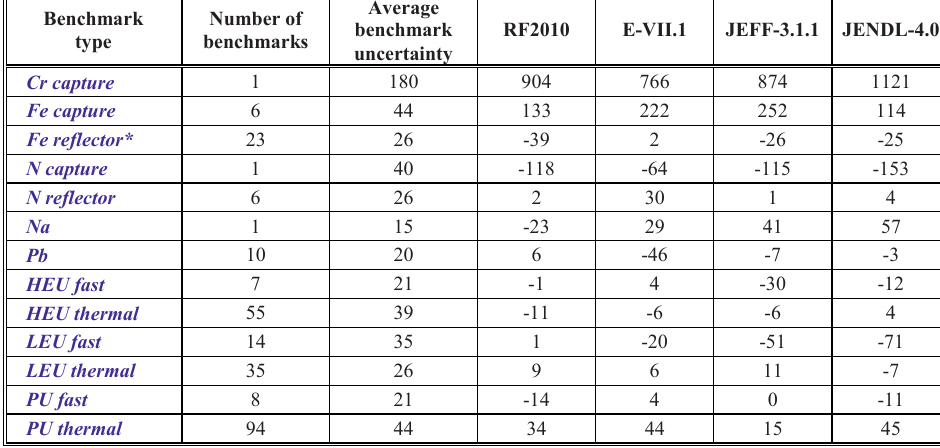
Table 4. The average benchmark uncertainties and the results for C/E-1 for benchmark set (in pcm).